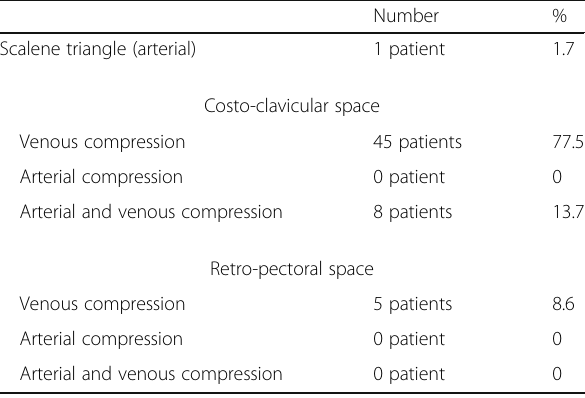
Table 2 Demonstrating the site of vascular compression in the study as well as the patients ’ number and percent Number % Scalene triangle (arterial) 1 patient